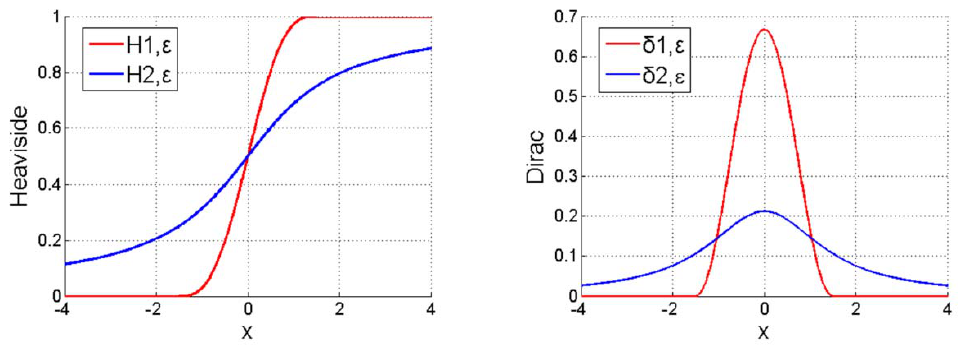
Figure 2. Profiles of the commonly used Heaviside function and Dirac function.